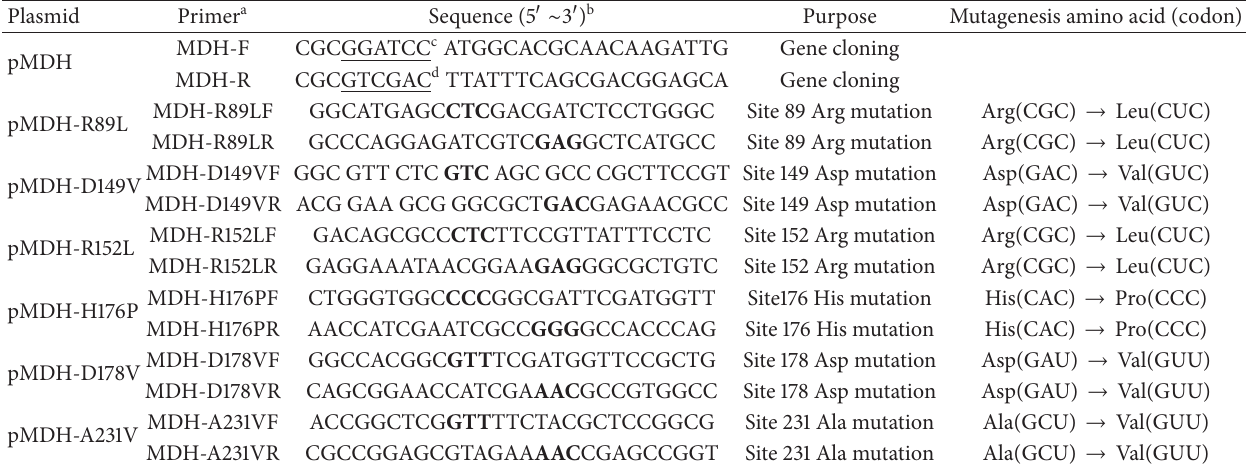
Table 1: Primers used for site mutation.